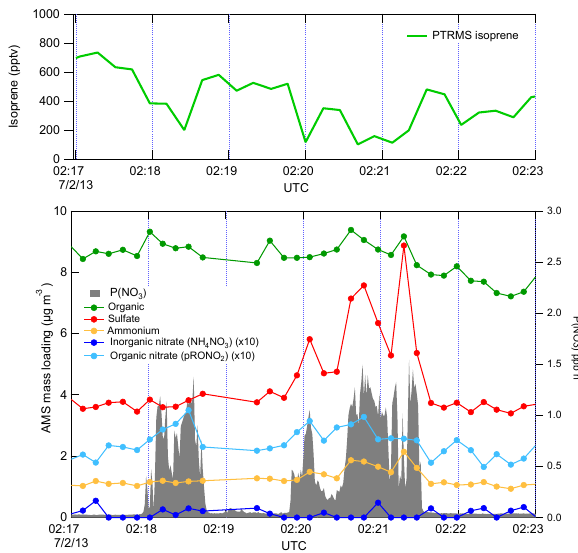
Figure 2. Three representative plume transect observations from the 2 July 2013 flight (plumes are identified by the peaks in P (NO 3 ), listed in Table 1 at times 02:18, 02:20, and 02:21UTC). Note the difference in sulfate enhancement in the three plumes, which is largest in the third plume, and is accompanied by increases in am- monium. In all three cases, the isoprene concentration drops in the plumes, accompanied by a clear increase in organic nitrate, no changes in the inorganic nitrate, and modest changes in organic aerosol mass